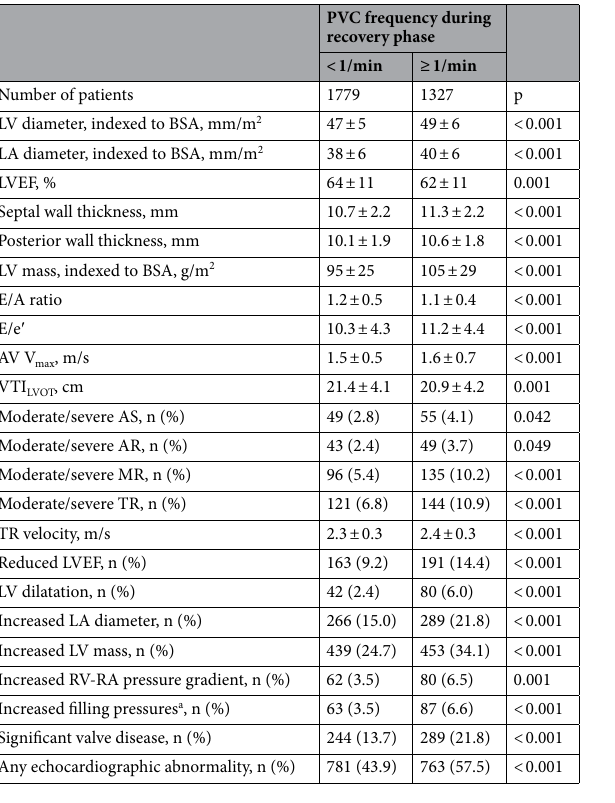
Table 2. Echocardiographic outcomes stratified by occurrence of premature ventricular contractions during the recovery phase. Data presented as mean ± standard deviation or n (%). Data on LVEF, LV diameter, LA diameter and E/e ′ were available in all 3106 cases, data on BSA-indexed value for LV diameter, LA diameter and LV were available in 3046 cases, data on RV/RA pressure gradient were available in 1949 cases. AR aortic regurgitation, AS aortic stenosis, BSA body-surface area, LA left atrial, LV left ventricular, LVEF left ventricular ejection fraction, MR mitral regurgitation, PVC premature ventricular contractions, TR tricuspid regurgitation. a Increased LV filling pressures were defined as E/e ′ ≥ 15 and a dilated LA, or E/e ′ ≥ 15 and an increased RV–RA pressure gradient.